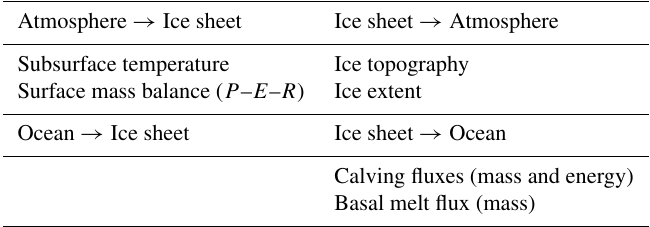
Table 10. Variables exchanged between the atmosphere model IFS and the ice sheet model PISM, as well as between the ocean model NEMO and ice sheet model PISM. Information is exchanged once a year with monthly